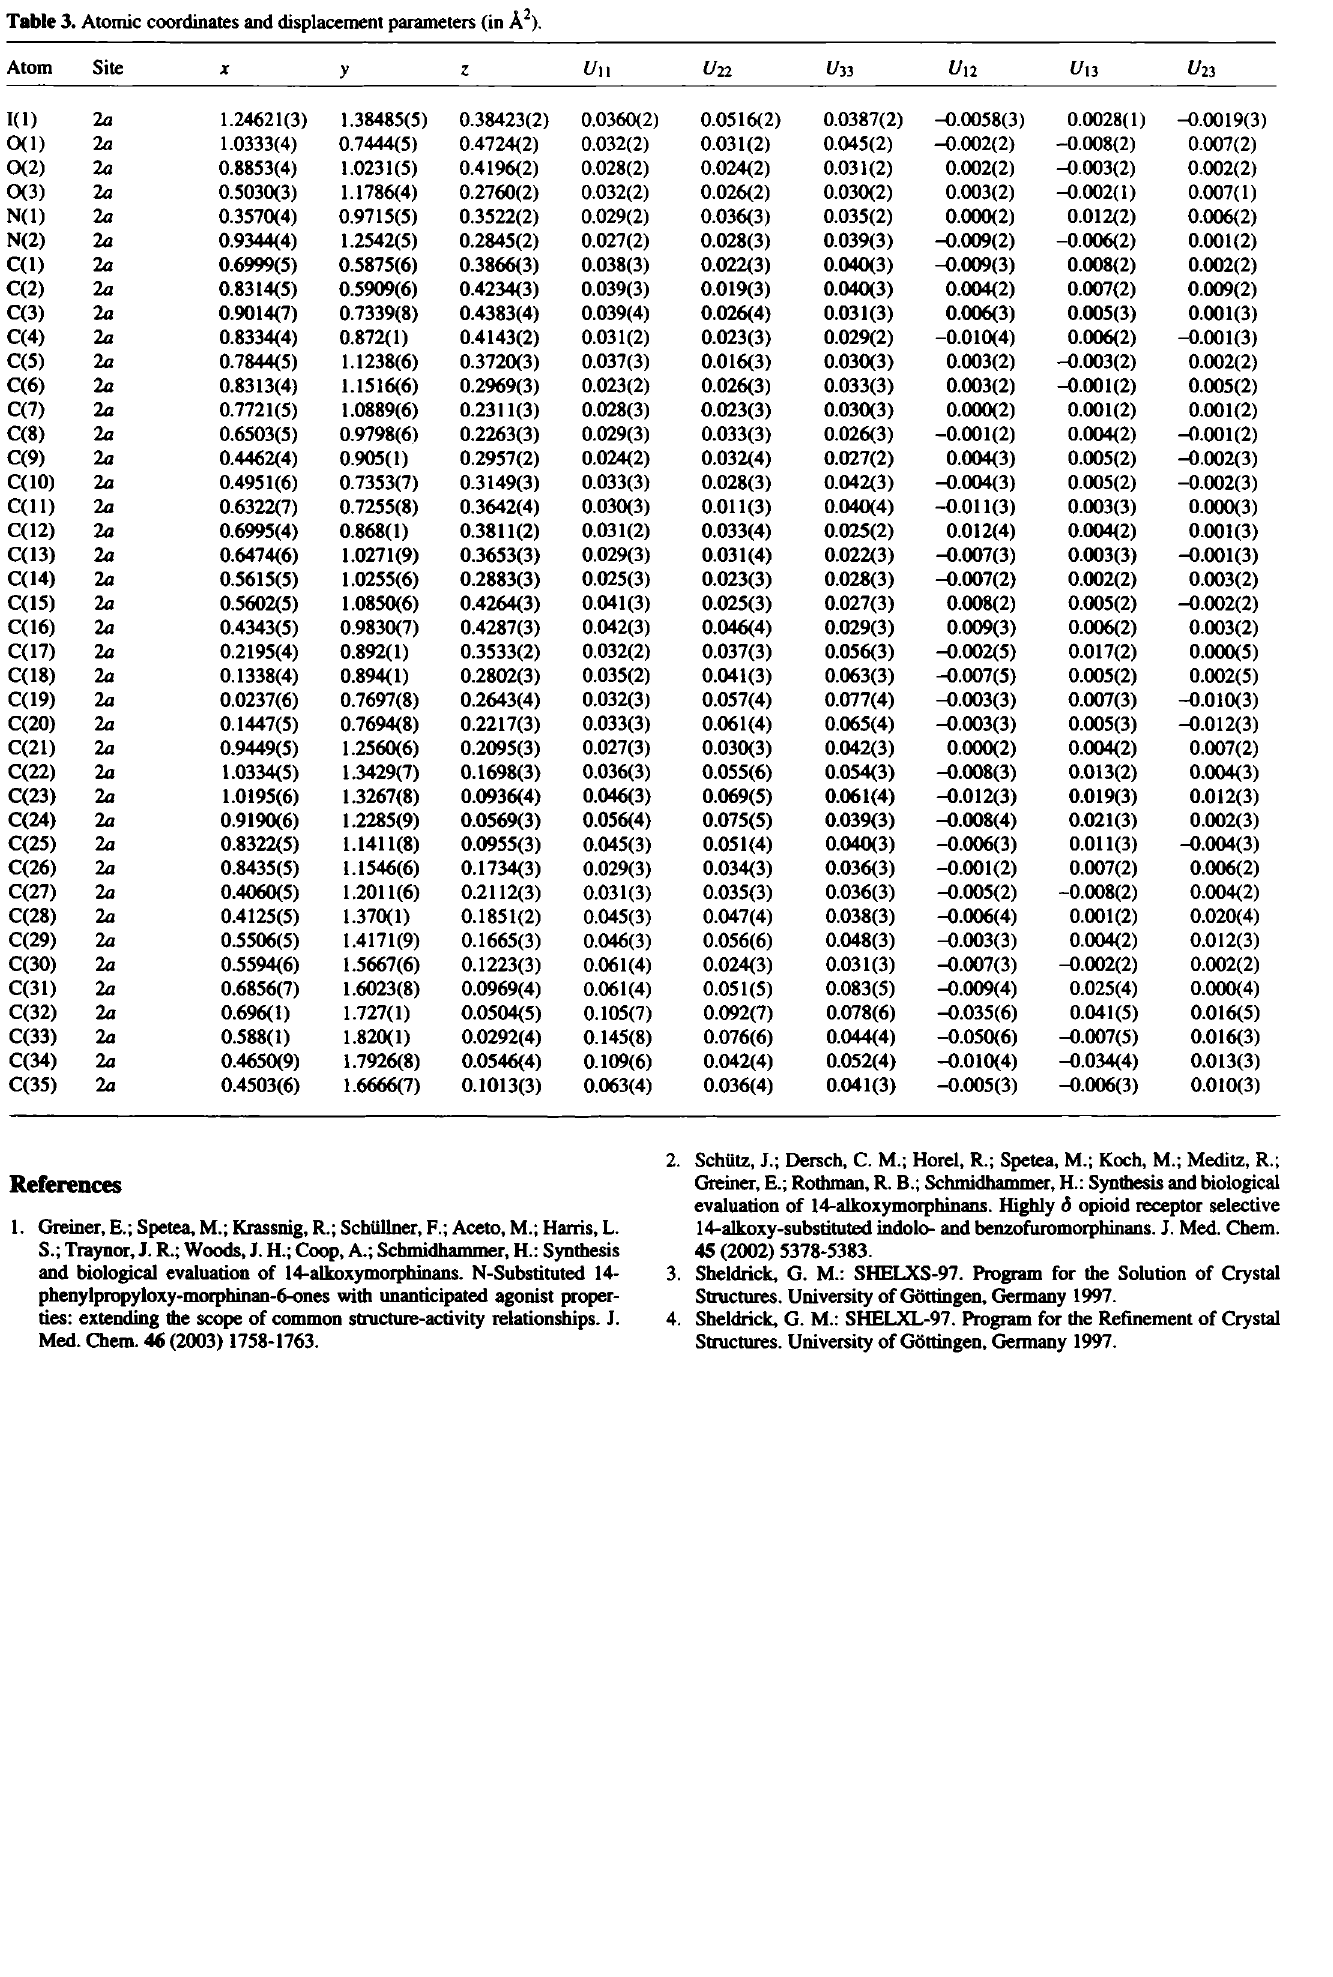
Table 3. Atomic coordinates and displacement parameters (in A 2